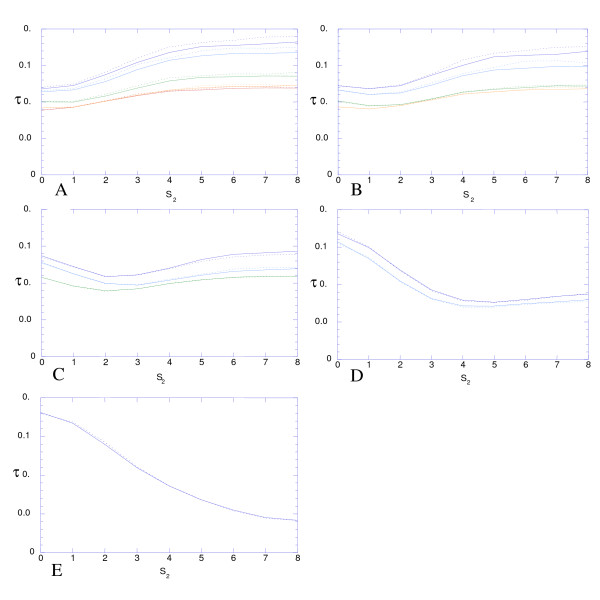
The same as Figure 3, but, for each mode of selection, the half-approach period presented in the average of its values obtained under 1000 randomly generated matrices of μi, j, in which values of μi, j were drawn independently from a uniform distribution that varied between 0.5 and 1.5 and the matrices were symmetric (solid lines) or arbitrary (dotted lines).